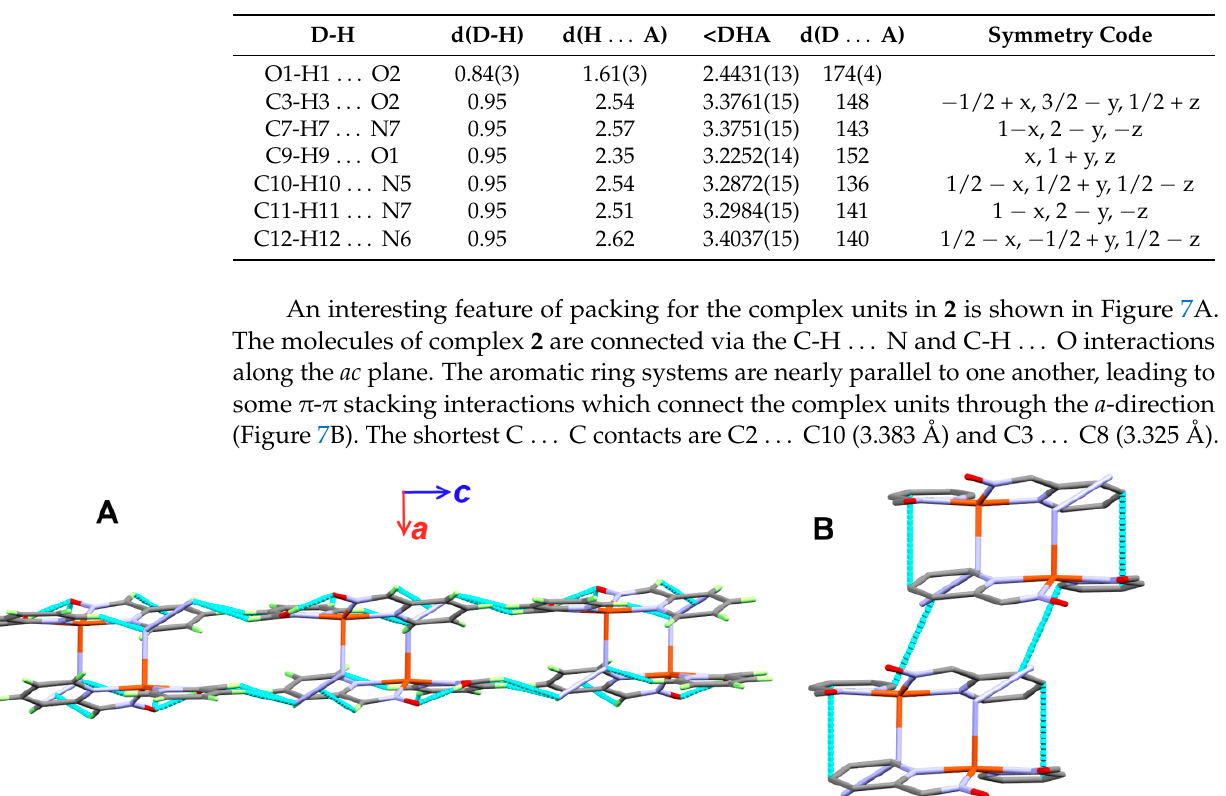
Table 5. Hydrogen bonds in complex 2 .